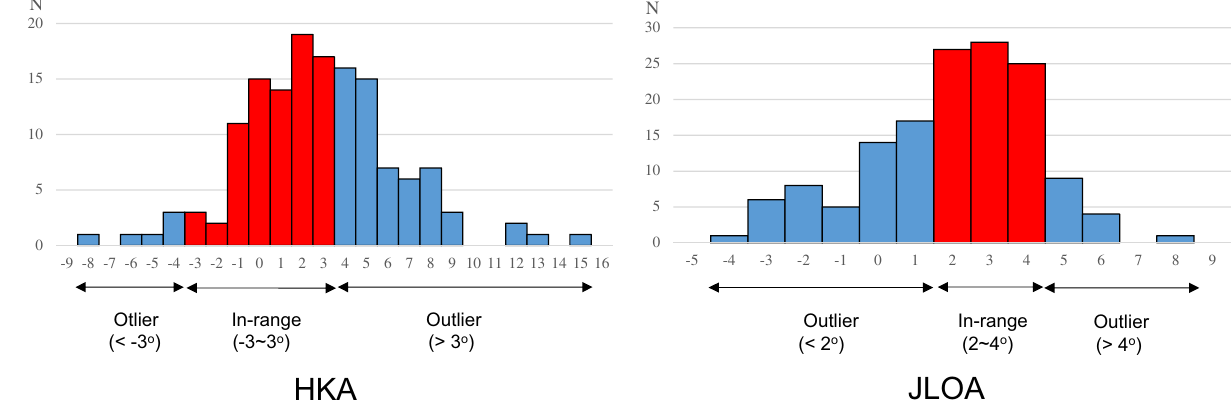
Figure 3. Distribution of the in-range and the outlier groups in a total of 145 knees. When the knees were classified according to the HKA axis, 81 knees (55.9%) were assigned to the in-range group (− 3 to 3°) (left, red bars), and 64 knees (44.1%) were assigned to the outlier group (< − 3° or > 3°) (left, blue bars). When classified according to the JLOA, 80 knees (55.2%) were assigned to the in-range group (2–4°) (right, red bars), and 65 knees (44.8%) were assigned to the outlier group (< 2° or > 4°) (right, blue bars). HKA: hip-knee-ankle; JLOA: joint line orientation angle.